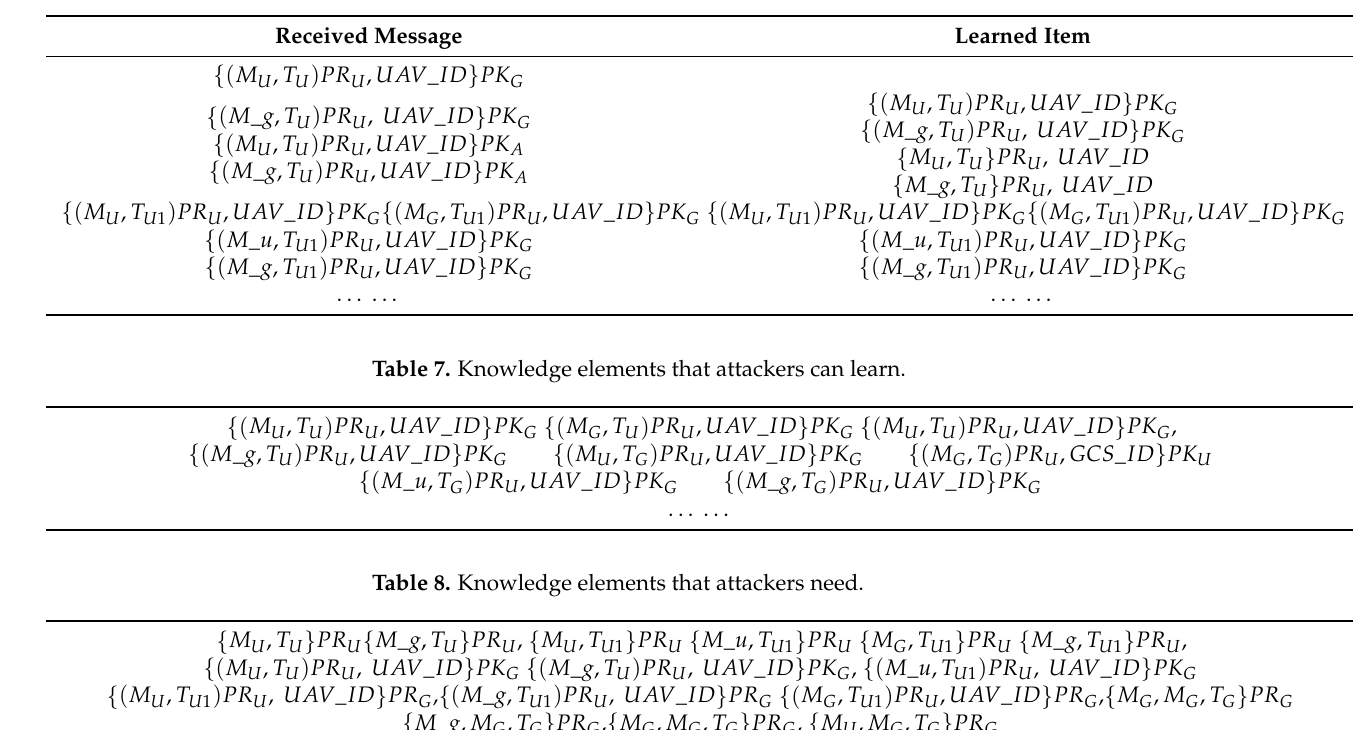
Table 6. Knowledge elements that attackers can eventually acquire.